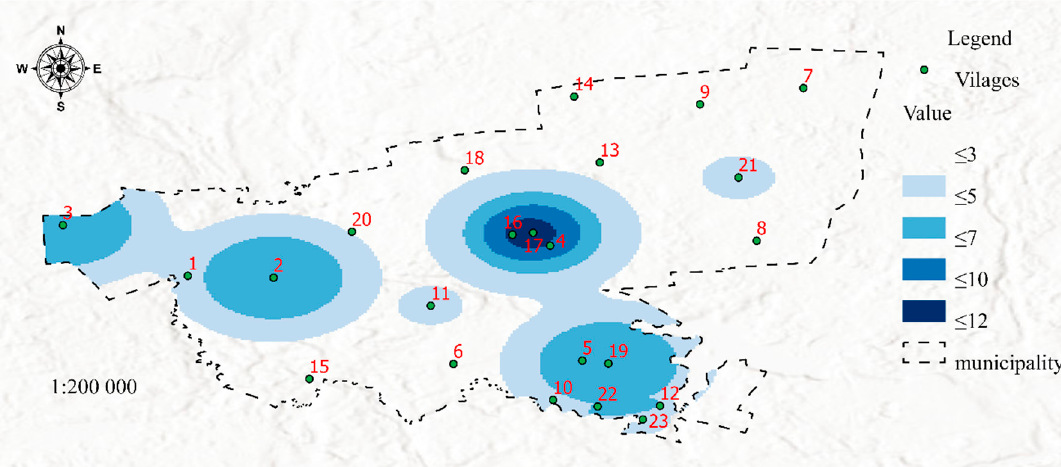
Figure 6. Map 4—Visualization of areas affected by violence (dataset 4). Source: Own elaboration.